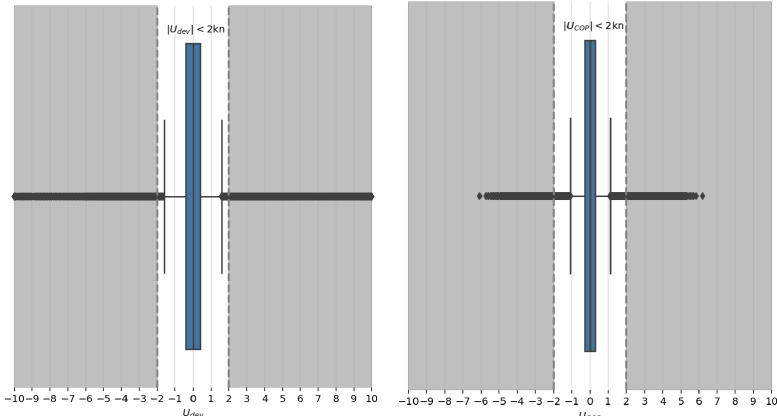
Figure 13. Distribution boxplots of U dev and U COP for 190 container ships.